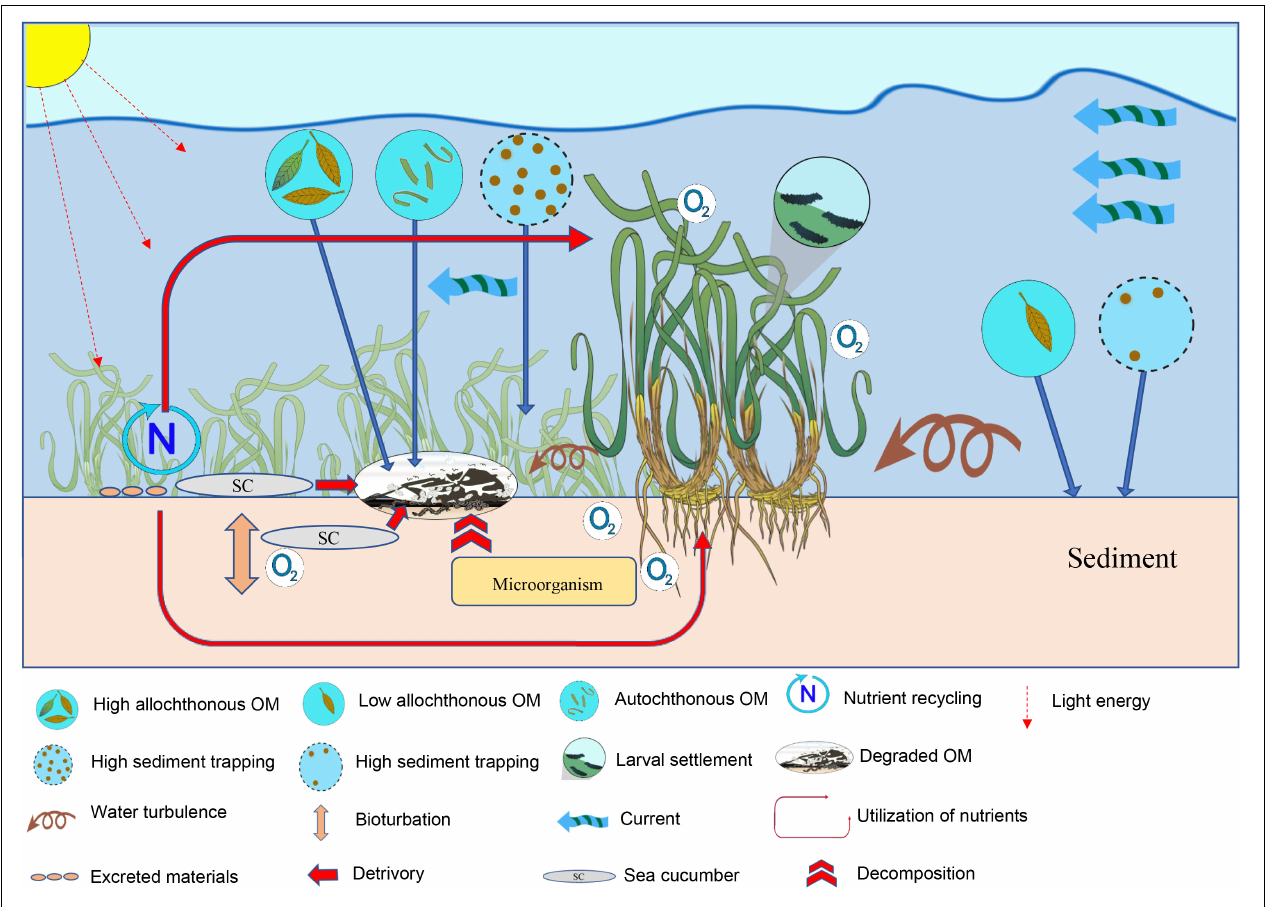
FIGURE 1 | Conceptual model of the seagrass-sea cucumber interactions in the seagrass